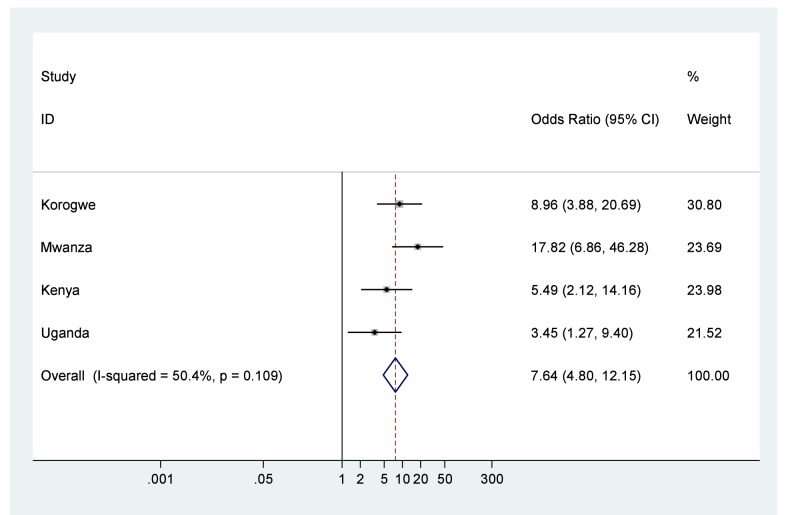
Neonatal mortality outcomes for babies with birth weight <2,500 g compared to babies with birth weight ≥2,500 g.Note: 95% CI for I
2 was 0%–83.6%.